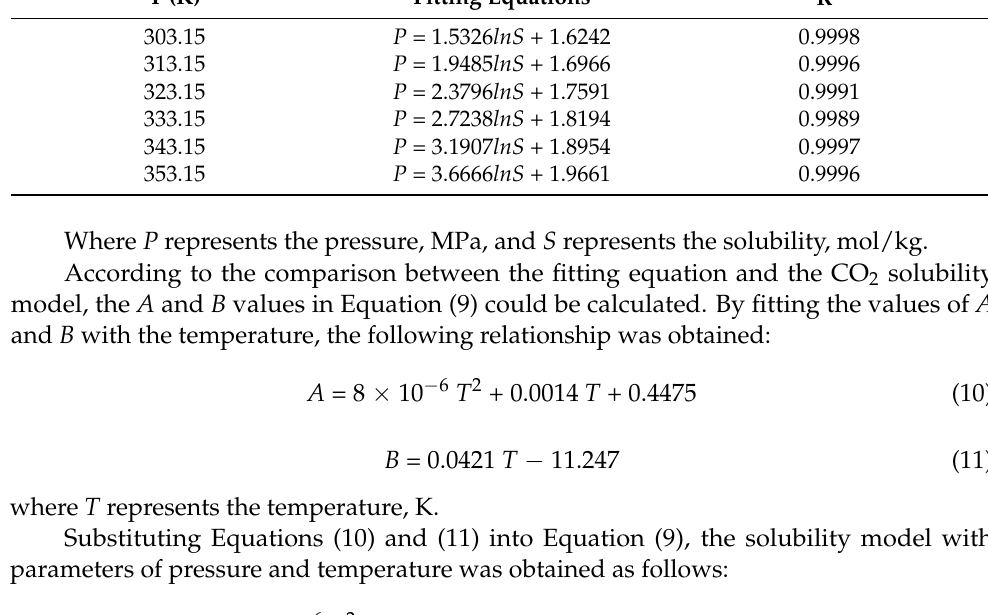
Table 9. Fitting equations of solubility and pressure of CO 2 + n -decane system. T